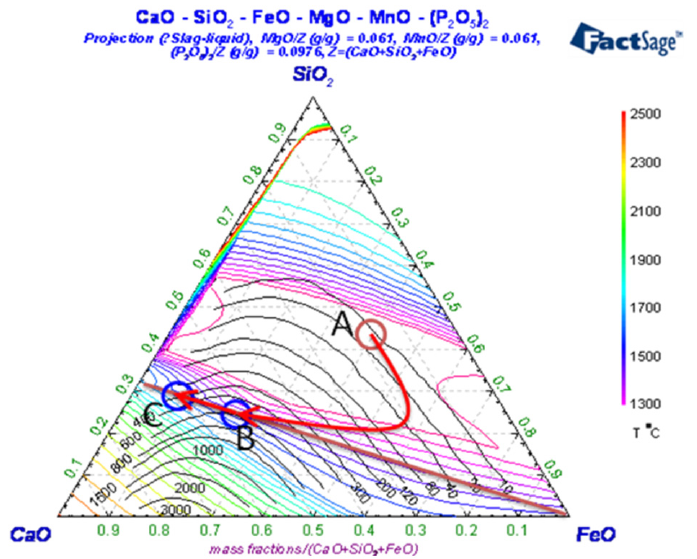
Figure 5. Theoretic slag-forming route.